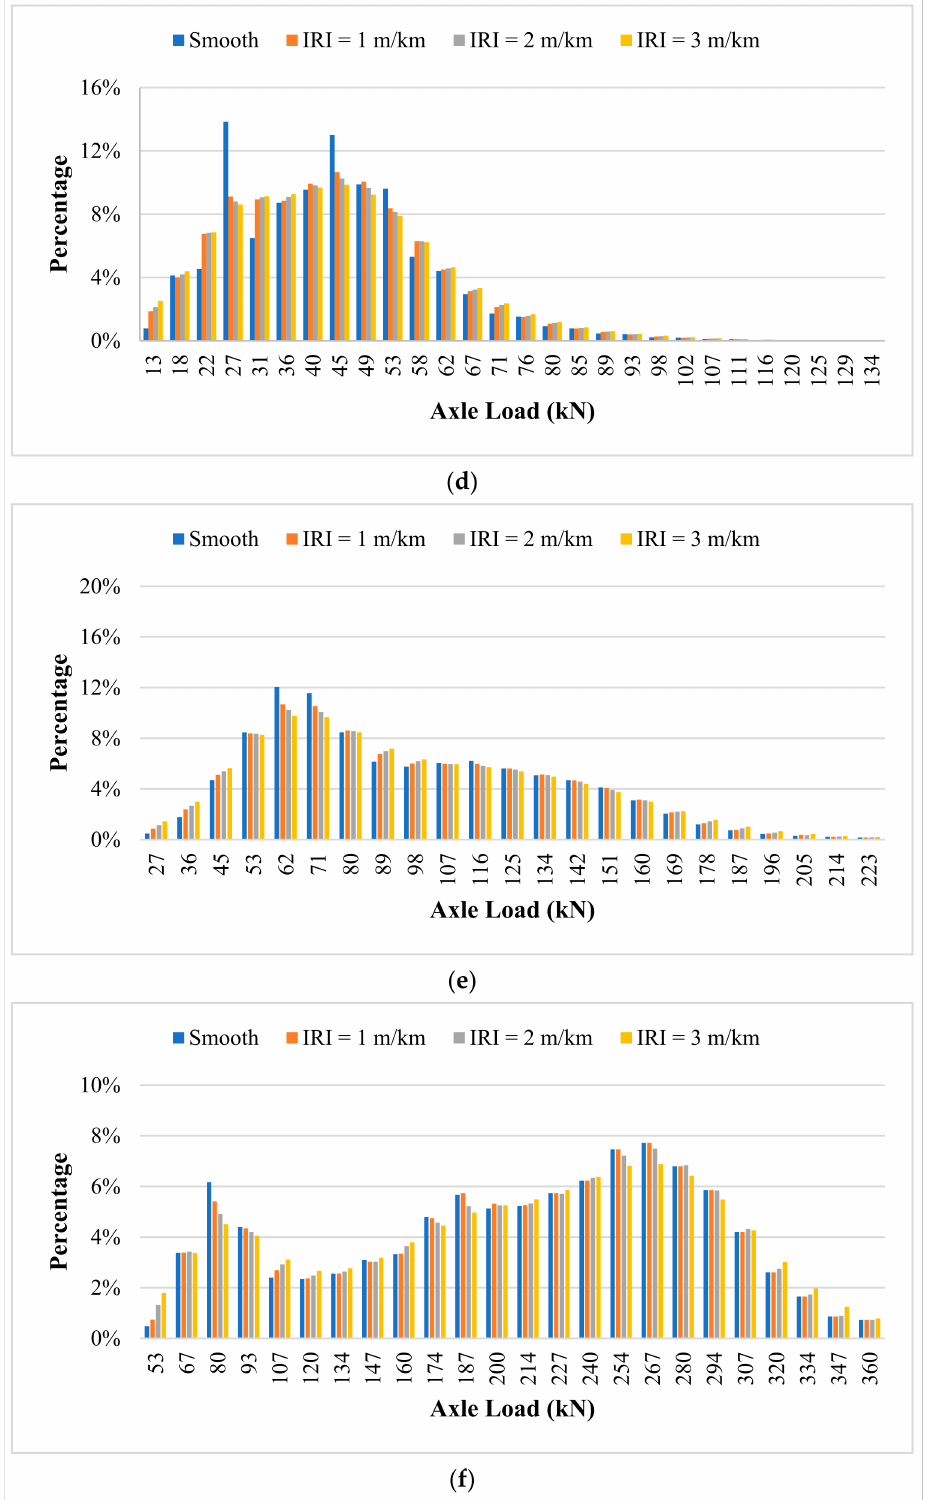
Figure 4. Static and dynamic axle load spectra: ( a ) single axle (major); ( b ) tandem axle (major); ( c ) tridem axle (major); ( d ) single axle (minor); ( e ) tandem axle (minor); and ( f ) tridem axle